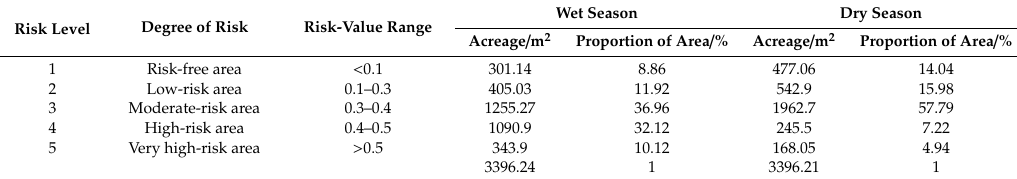
Table 5. Criteria of soil salinity risk classification and area-statistics at each risk rating in study area.